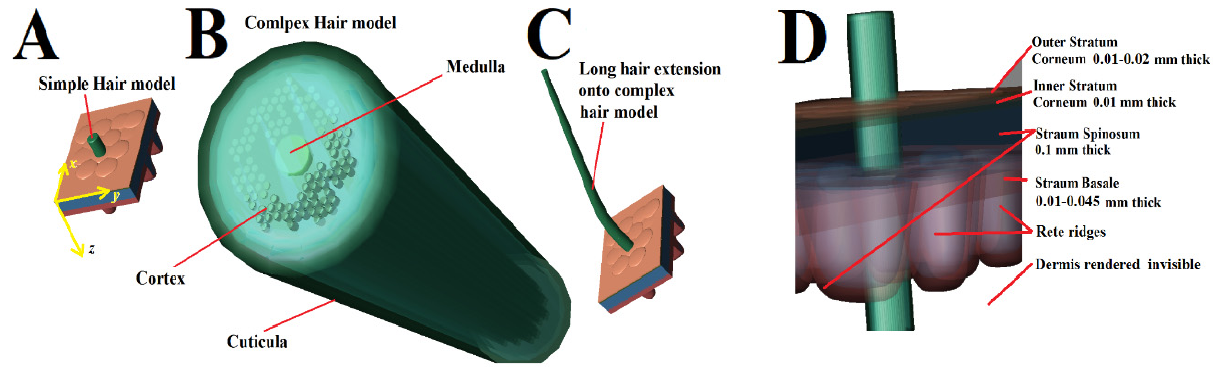
Figure 1. Dermis is rendered invisible in the illustrations. ( A ) The basic hair model, with a solid hair rod, 0.05 mm radius, and total length 0.6 mm, extending 0.15 mm above the skin. ( B ) Complex hair model, with external dimensions and placement as in ( A ) but with internal structure of a cortex containing microfibrils and a medulla. ( C ) An extension adding a 1.7 mm bent, conical, tapering shaft to the complex model. ( D ) Detail of the skin layers, thin skin.